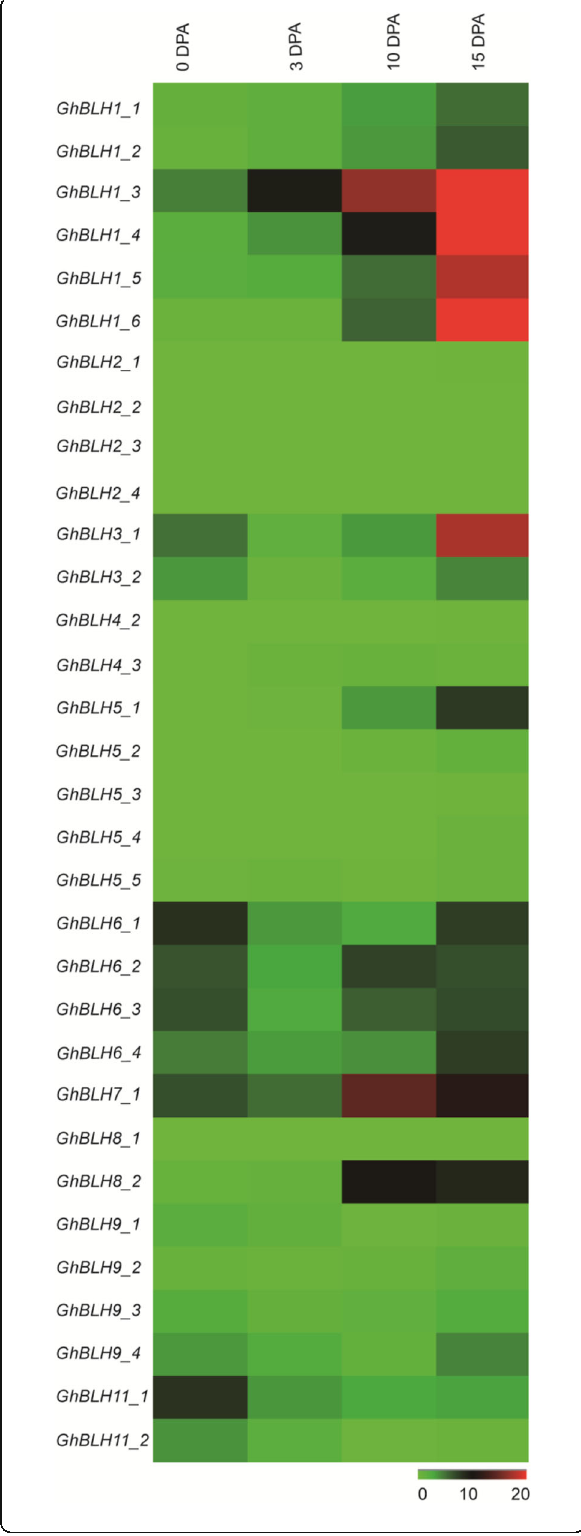
Fig. 4 Gene expression analysis of 32 BLH genes in G. hirsutum at 0, 3, 10, 15 DPA samples. 0 and 3 DPA samples were ovules. 10 and 15 DPA samples were fiber cells. For expression analysis of GhBLH genes at different fiber developmental stages, publicly available gene expression files (0 – 15 DPA) were obtained from CottonGen (https://www.cottongen.org/). A heat map was created using MEV software (Eisen et al. 1998). The expression levels are indicated by the color bar: red means high and green means